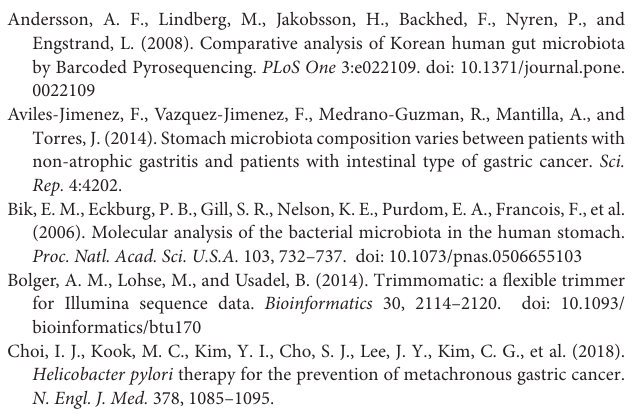
Supplementary Figure 7 | Changes in gastric microbiota at the corpus in H. pylori -uninfected individuals without atrophic gastritis/intestinal metaplasia (Group 1, n = 8). Supplementary Figure 8 | Changes in gastric microbiota after H. pylori eradication. In 10 patients both microbiota composition and microbial diversity appeared to be restored (A) , but in 11 patients they were not restored (B) . Supplementary Figure 9 | Changes in gastric microbiota in subjects with persistent H. pylori infection. A -diversity indices (Shannon index, A ; Phylogenetic diversity, B ) and bacterial composition (C) were not changed significantly. Supplementary Figure 10 | Gastric microbiota in patients with persistent H. pylori